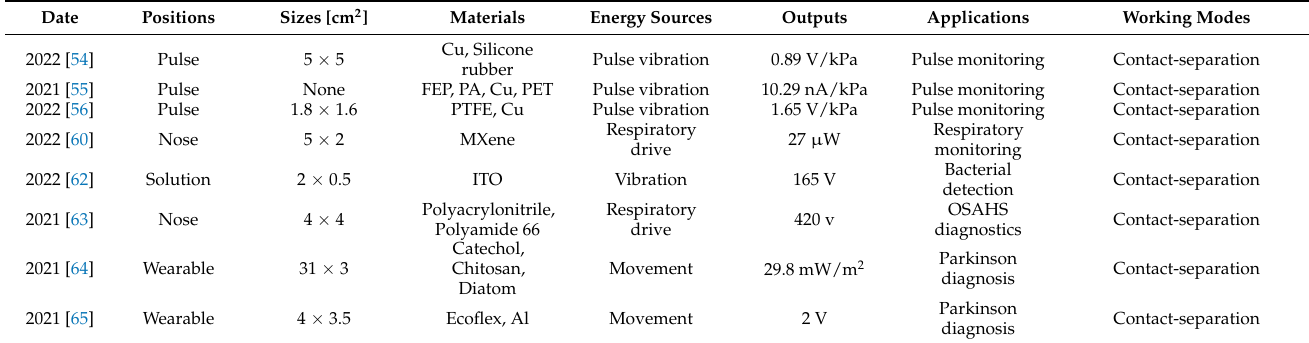
Table 2. Summary of TENG